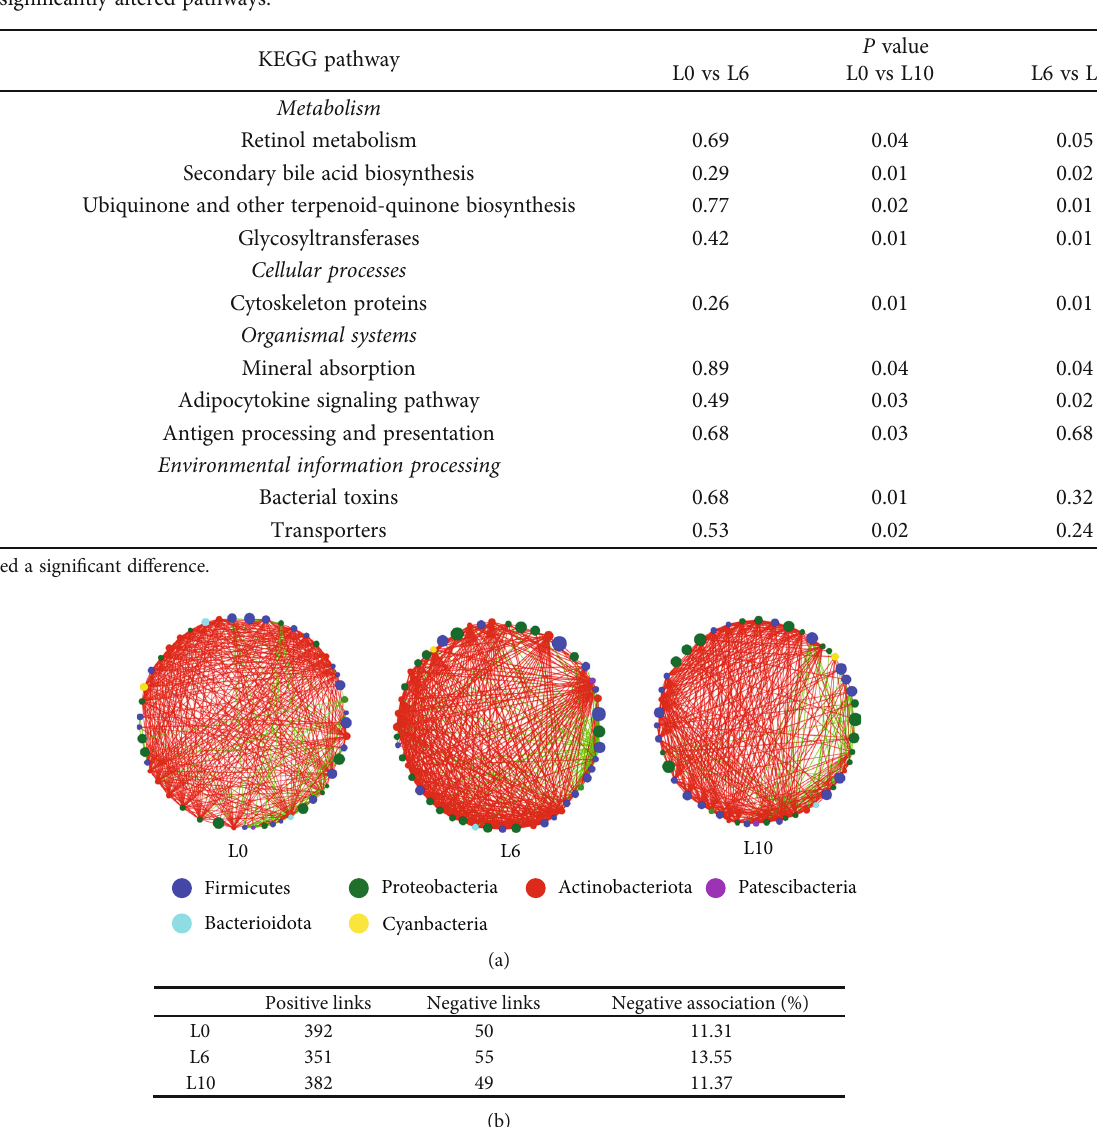
Table 6: Predicted functions of gut microbiota in C. quadricarinatus fed diets with di ff erent lipid levels. KEGG level 1 and level 3 are listed following the signi fi cantly altered pathways.